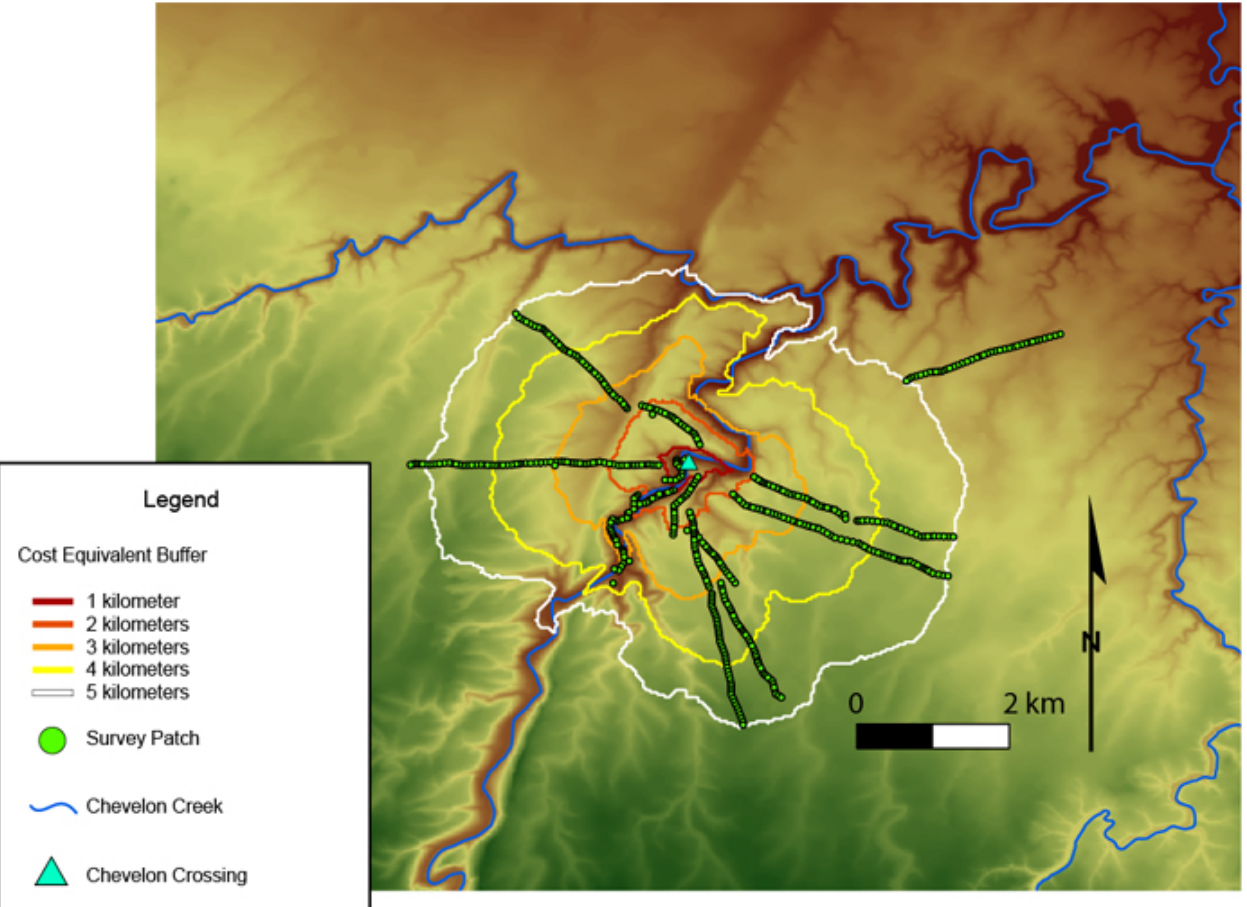
Fig. 3. The Chevelon Crossing study area showing transect units and individual survey